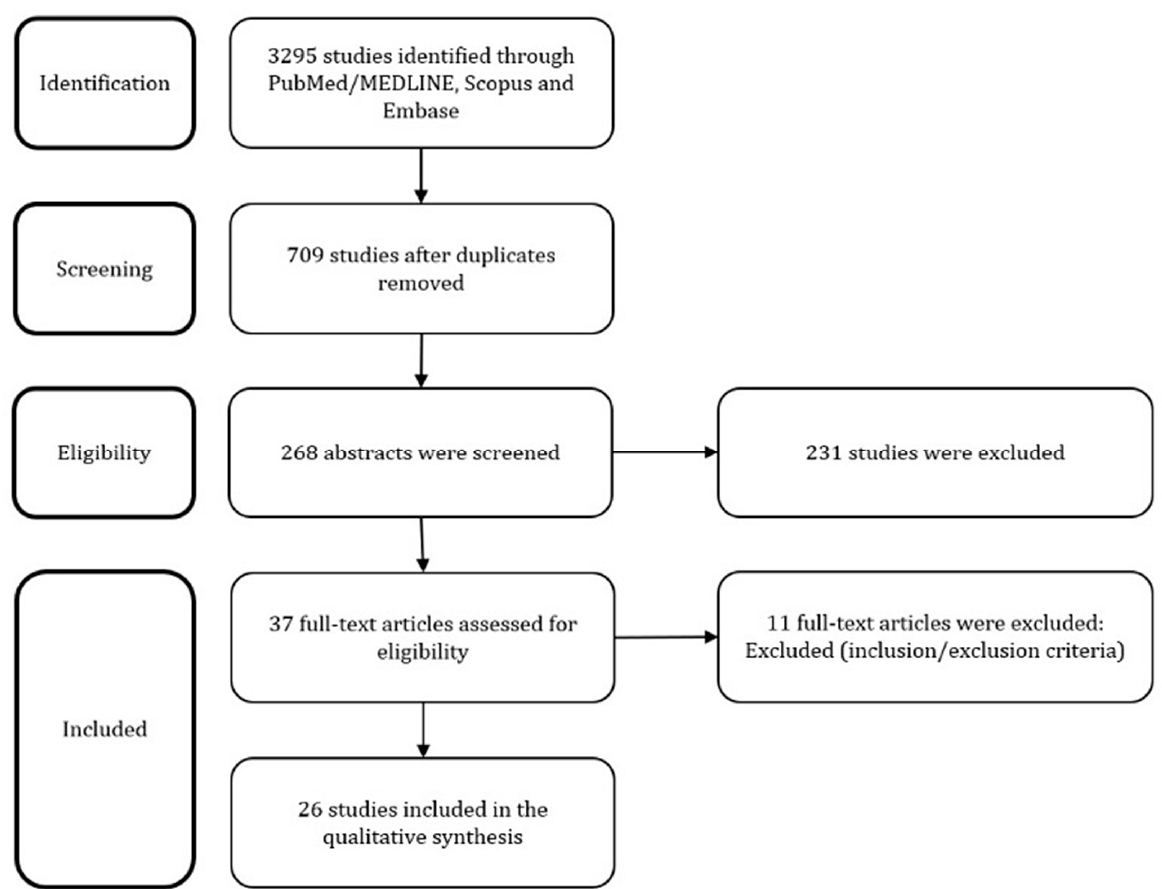
Figure 1. PRISMA Flow Diagram.